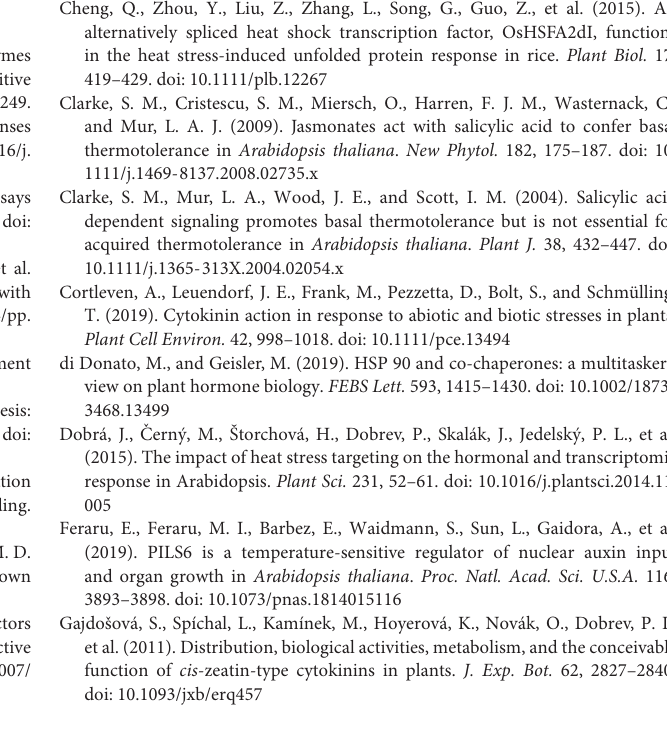
Supplementary Figure 1 | Setup of the insulated vessels. Supplementary Figure 2 | Jasmonoyl-isoleucine. Supplementary Table 1 | List of primers. Supplementary Table 2 | RT-qPCR. Supplementary Table 3 | Phytohormone